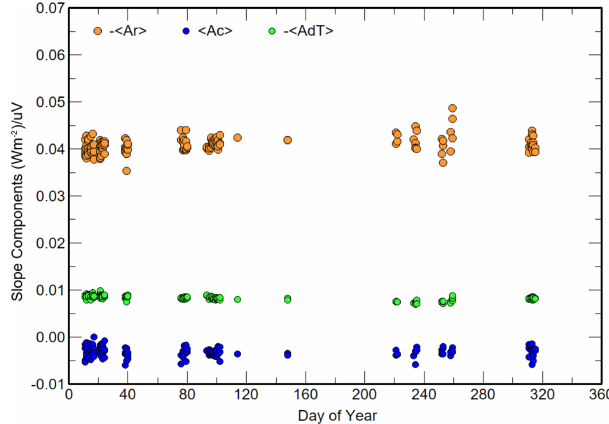
Figure 4. The linear LSQ slope <A r > , <A c > and <A d T > com- ponents that generate <K 1 > for 244 calibrations in 2020.